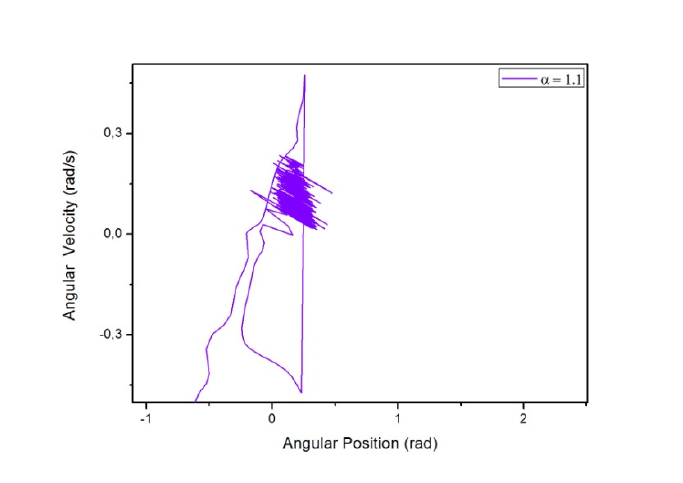
Figure 18. Pseudo-phase portrait (Case B for α =